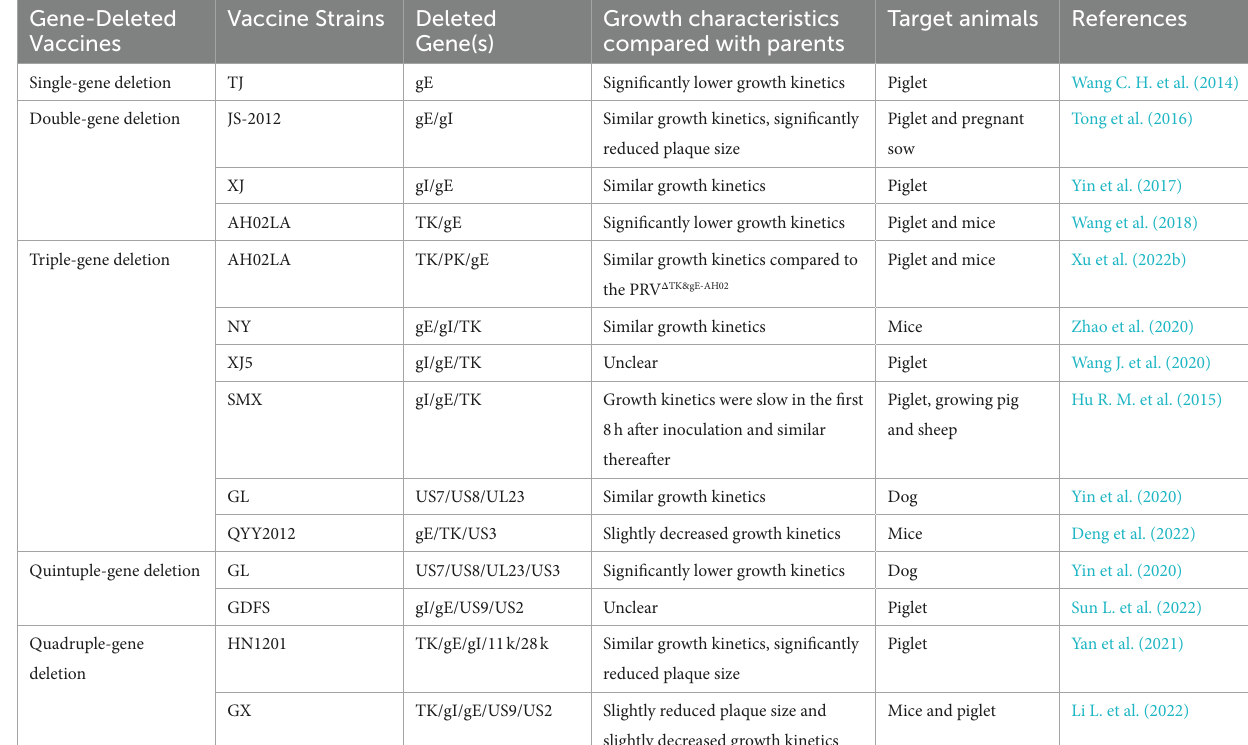
TABLE 2 Overview of live attenuated PRV